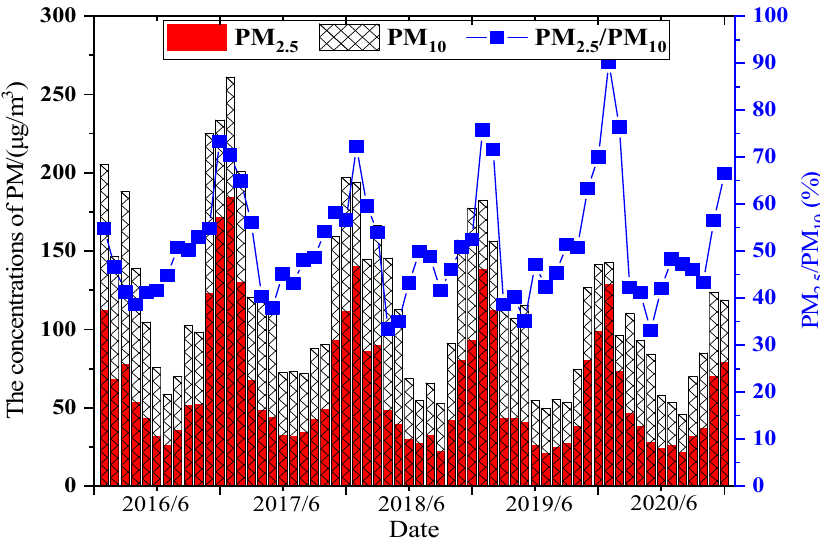
Figure 3. Monthly changes in PM 2.5 and PM 10 concentrations from 2016 to 2020.